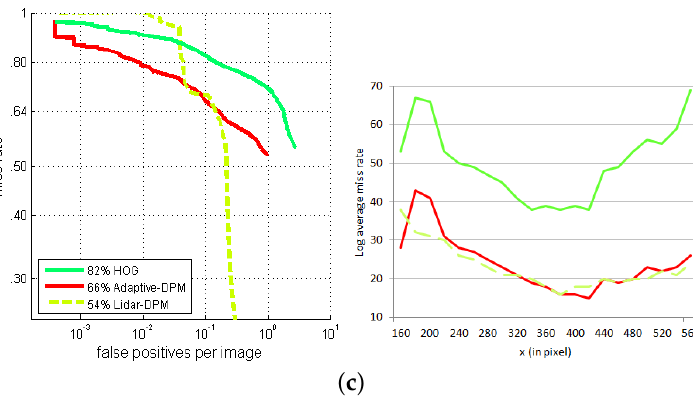
Figure 20. Comparison of detection performance between the exclusively vision-based approaches and the LiDAR-fisheye camera PDS in different machine operating states: ( a ) static, ( b ) turning and ( c )